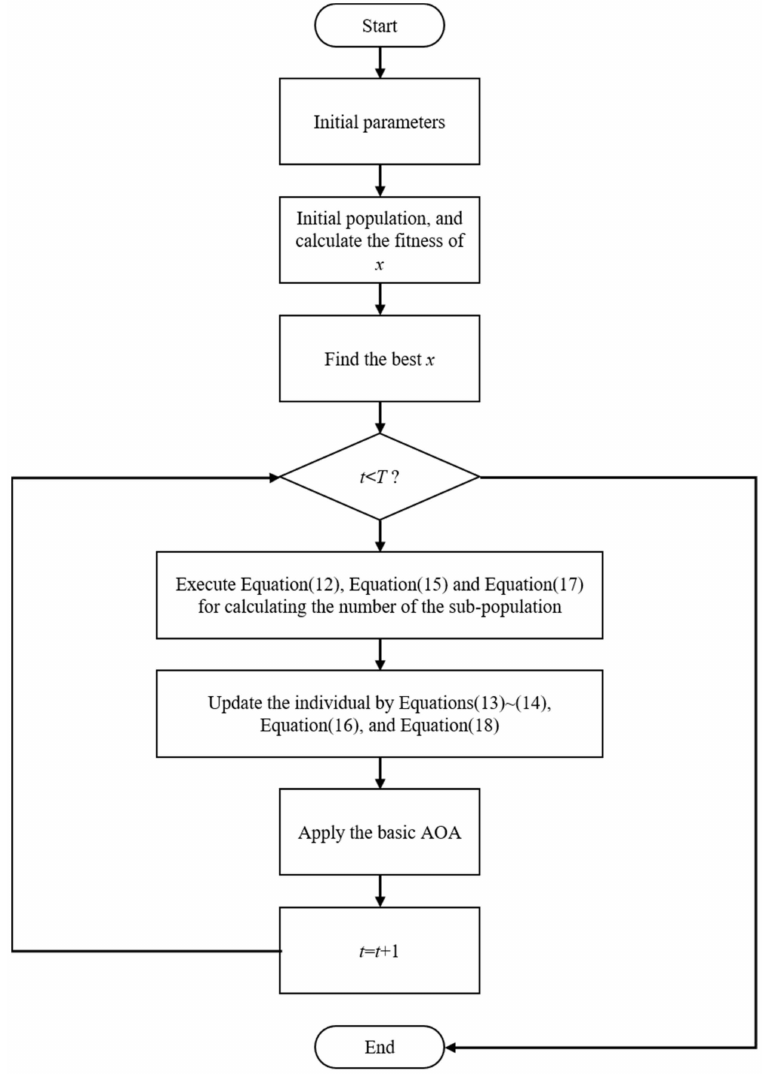
Figure 2. Flowchart of the